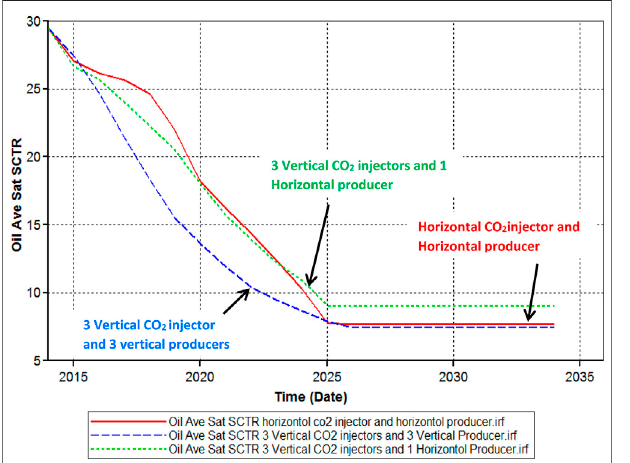
FIGURE 5 | Average oil saturation as a function of time for the three studied well con fi gurations.